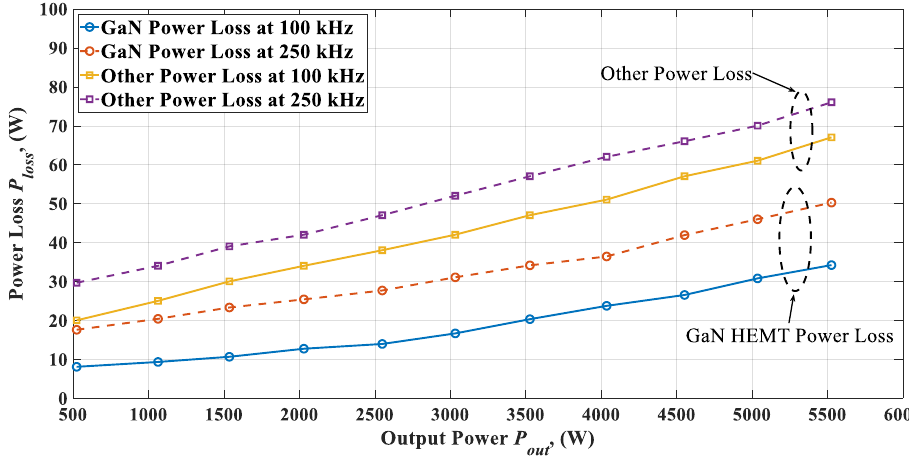
Figure 12. Loss distribution of the proposed converter at different output powers and two different switching